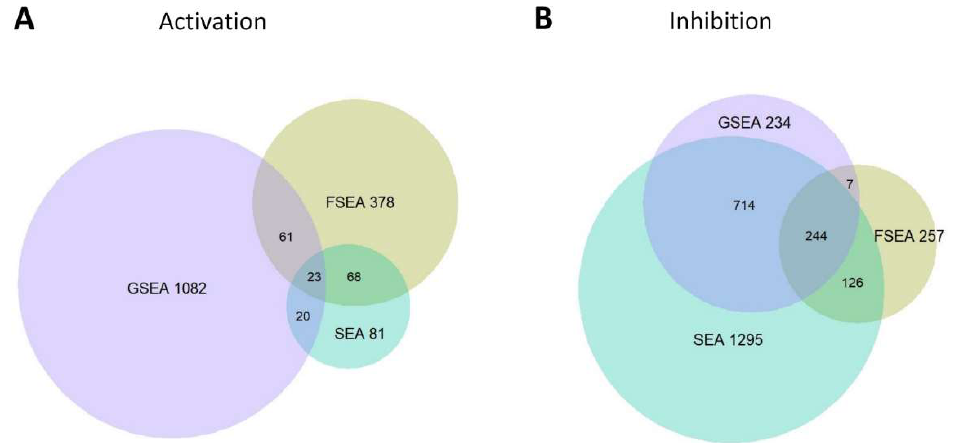
Figure 2. Summary statistics for the Gene Ontology (GO) terms detected by Fold-change-Specific Enrichment Analysis (FSEA), Gene Set Enrichment Analysis (GSEA), and Singular Enrichment Analysis (SEA) in comparison of transcriptomes between HPrEC and LNCaP cell lines (GSE70466). ( A ) Activation of gene expression. ( B ) Inhibition of gene expression.